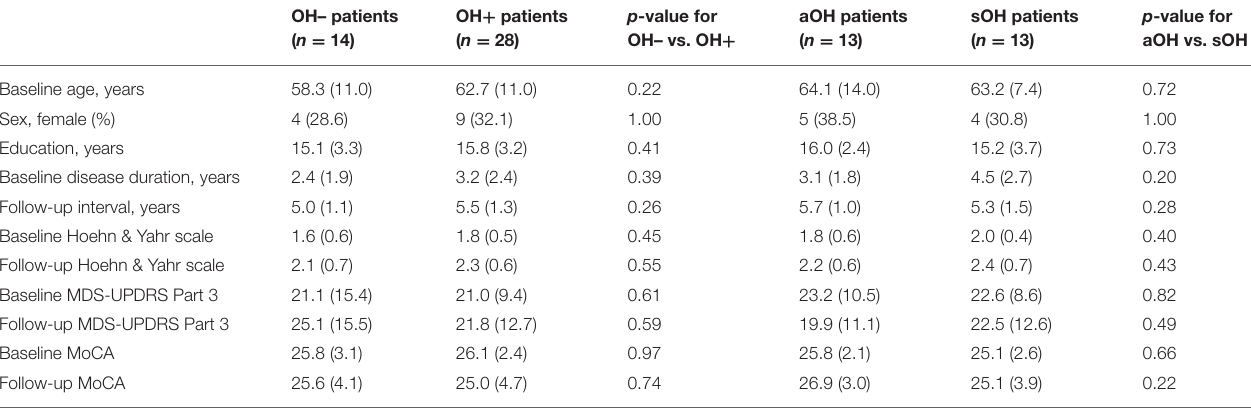
TABLE 2 | Comparison of demographic and clinical characteristics between Parkinson disease patients that remained without OH during the follow-up period (OH–) and patients without OH at baseline that developed OH during the follow-up period; and asymptomatic and symptomatic OH patients within the OH + group based on initial visit with